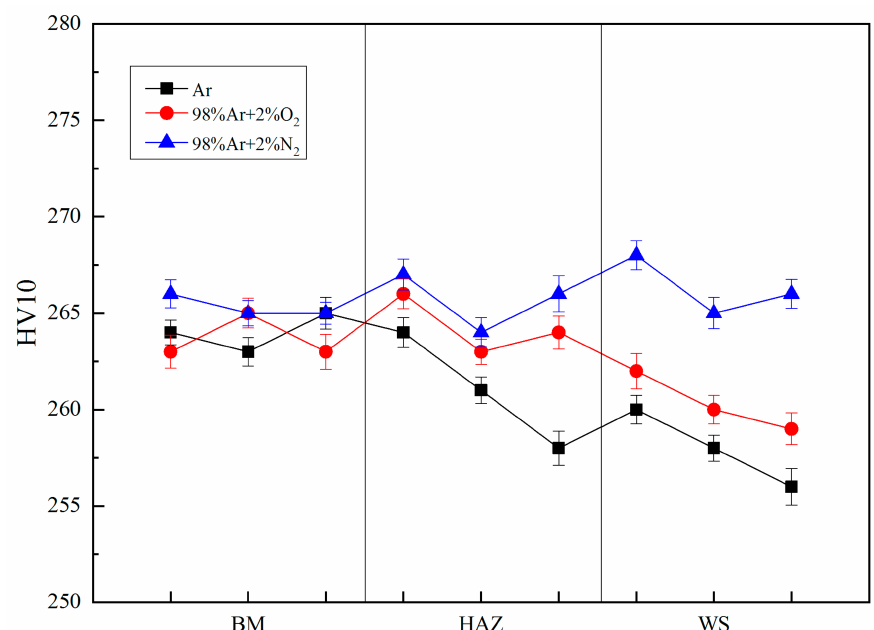
Figure 5. Hardness distribution chart.